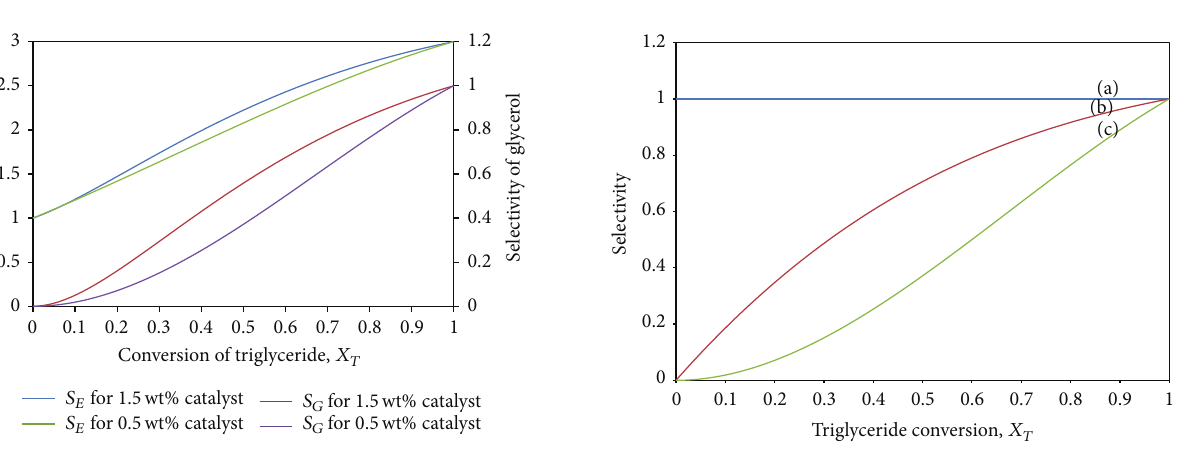
Figure 10: Selectivity plots: (a) methyl ester 1, (b) methyl ester 2, and (c) methyl ester 3 for dataset